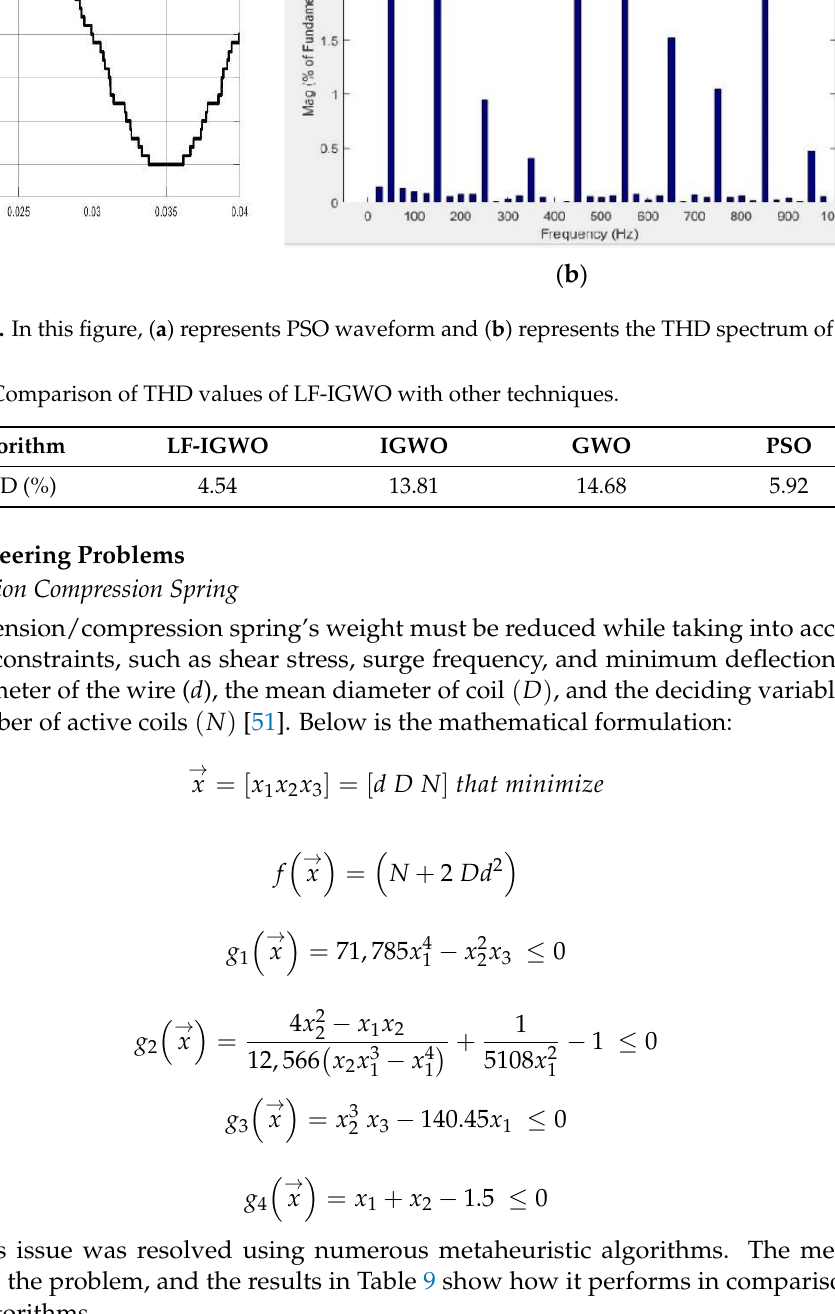
Table 10. Comparison of the data values of LF-IGWO with other techniques.